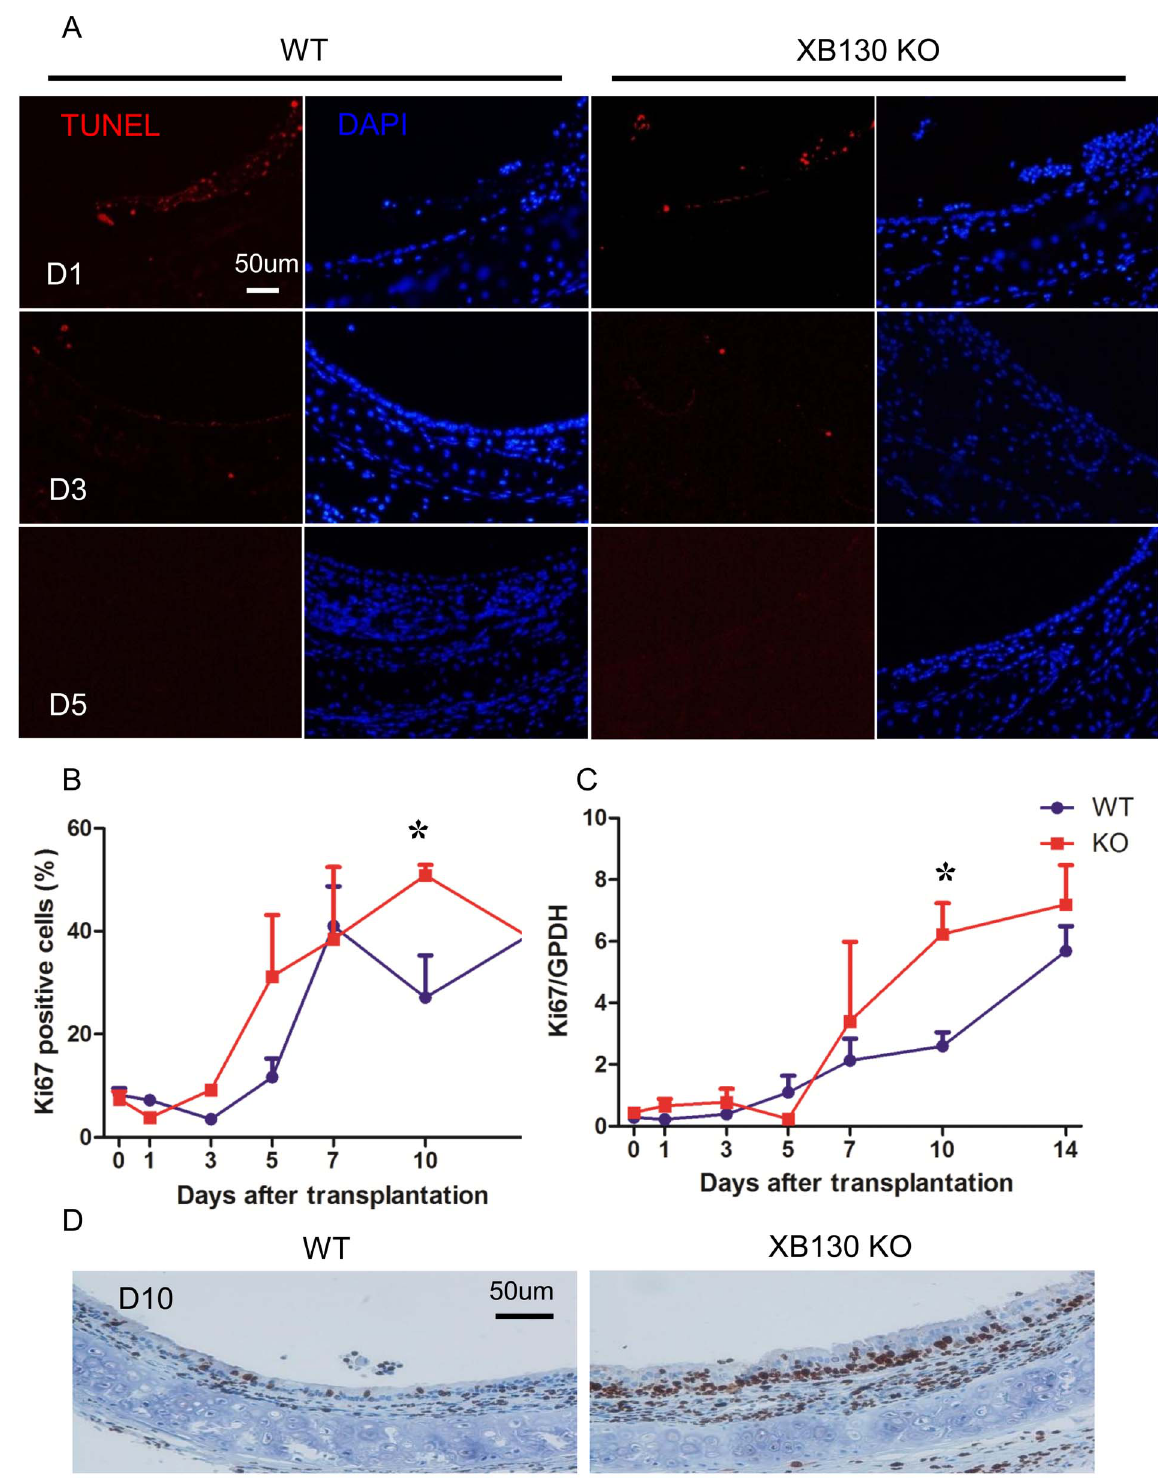
Figure 5. Xb130 KO tracheal epithelium exhibits comparable cell apoptosis but higher cell proliferation at Day 10 after isogenic tracheal subcutaneous transplantation. In both group, comparable tracheal epithelium apoptosis was observed at an early stage after transplantation (D1 and D3). After Day 5, no apoptosis cells were observed. After tracheal transplantation, the proliferation in both groups was reduced and then increased gradually (B and C). At Day 10 after transplantation, cell proliferation is significantly higher in Xb130 KO group as determined by Ki67 immunohistochemistry staining (B) and Ki67 mRNA expression (C). Representative Ki67 staining also showed increased thickening of connective tissue layer between the epithelium and cartilage, and fibroblast proliferation (D).